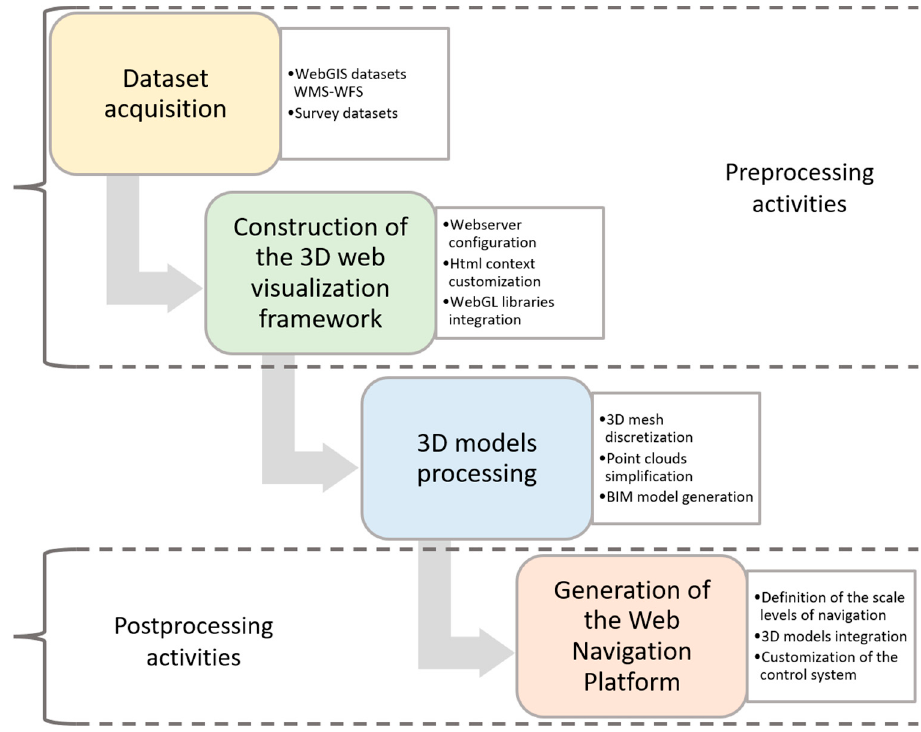
Figure 3. Platform development workflow. The dataset acquisition and the construction of the 3D web visualization framework constitute the preprocessing steps. Instead, the generation of the Web Navigation Platform regards the post-processing activities, when the processed 3D models are integrated inside it. Source: author.